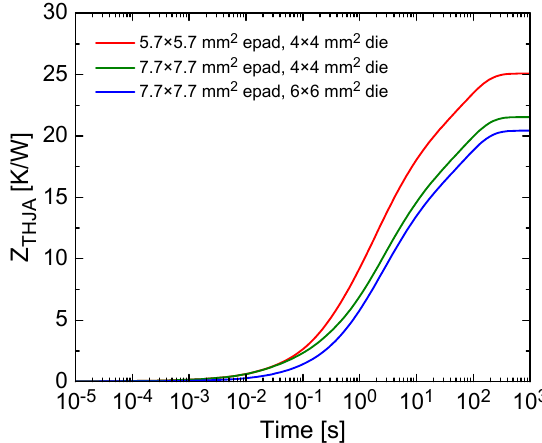
Figure 8. Thermal impedance Z THJA vs. time of a 9 × 9 mm 2 single-row eQFN package for three combinations of epad and die sizes.